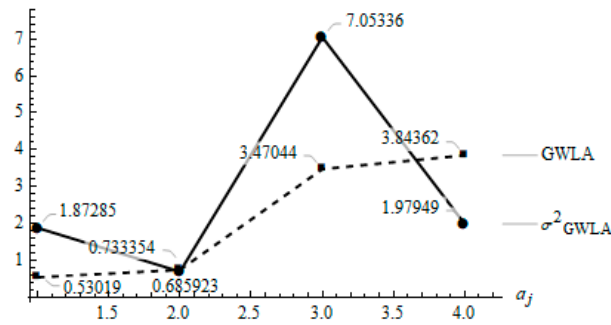
Figure 1. GWLA and 𝜎 (cid:2870) (cid:2891)(cid:2907)(cid:2896)(cid:2885) operators following conditions in Example 1. Figure 1. GWLA and σ 2 GWLA operators following conditions in Example